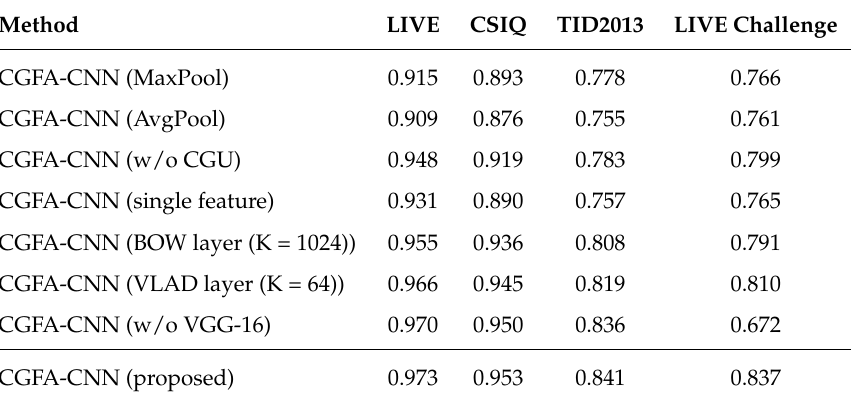
Table 7. SRCC with different